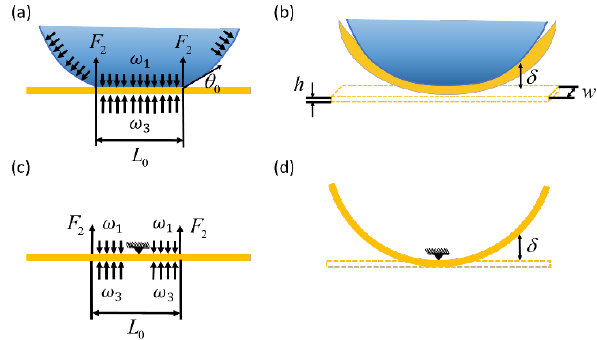
Figure 7. Electro-capillary transport scheme: ( a , b ) force illustration; ( c , d ) deformation model of a ribbon as the deflection of a cantilever beam.